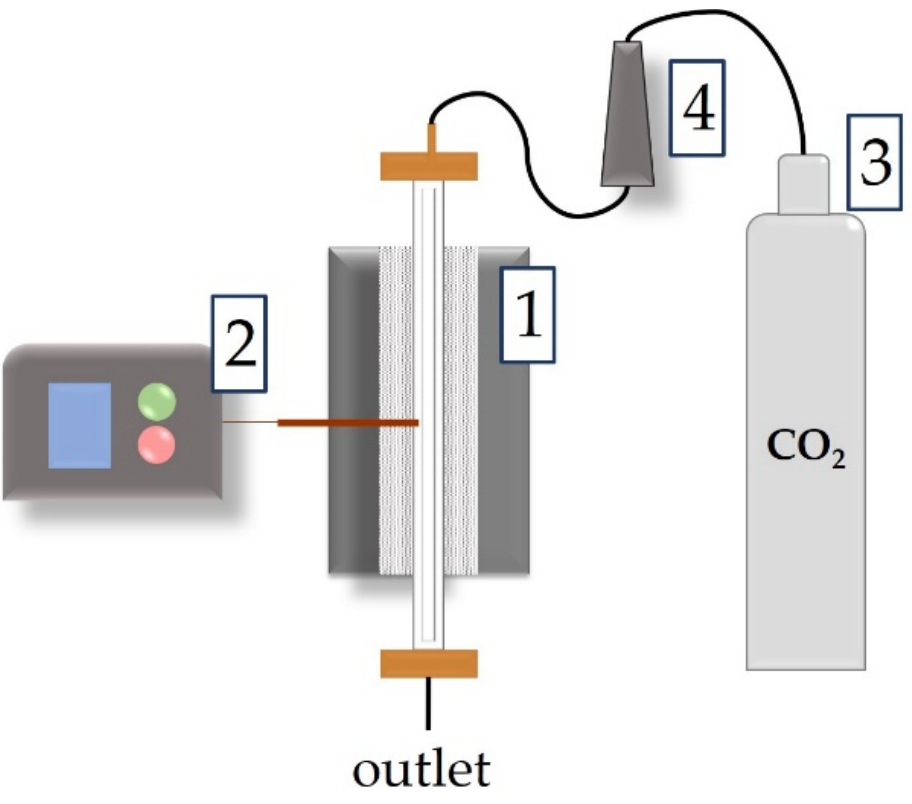
Figure 2. Scheme of the test rig: 1—fixed-bed vertical reactor, 2—temperature controller, 3—gas cylinder, 4—rotameter.